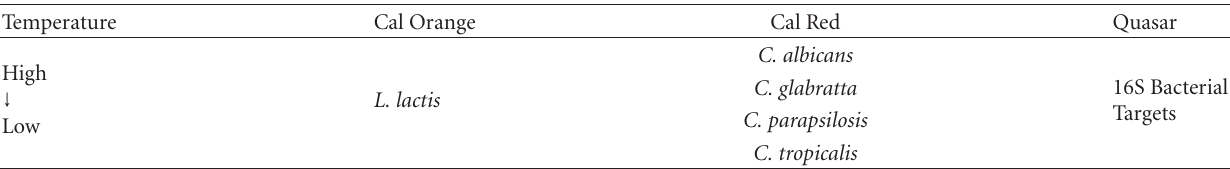
Table 1: 16S sepsis multiplex assay configuration.